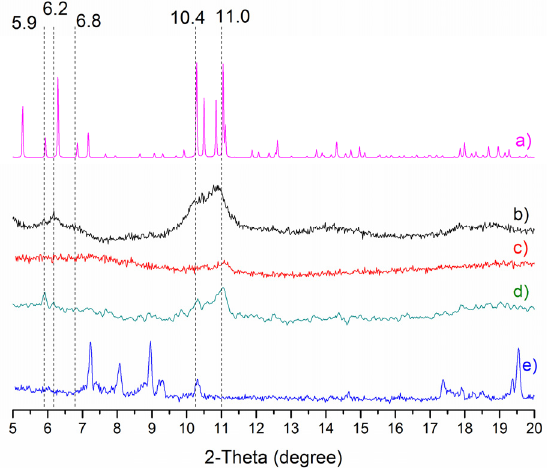
Figure 1. XRD patterns of simulated MIL-100(Cr) ( a ), MIL-100(Cr) ( b ), PW12@MIL-100(Cr) ( c ), PW4@MIL-100(Cr) ( d ) and PTA ( e ).